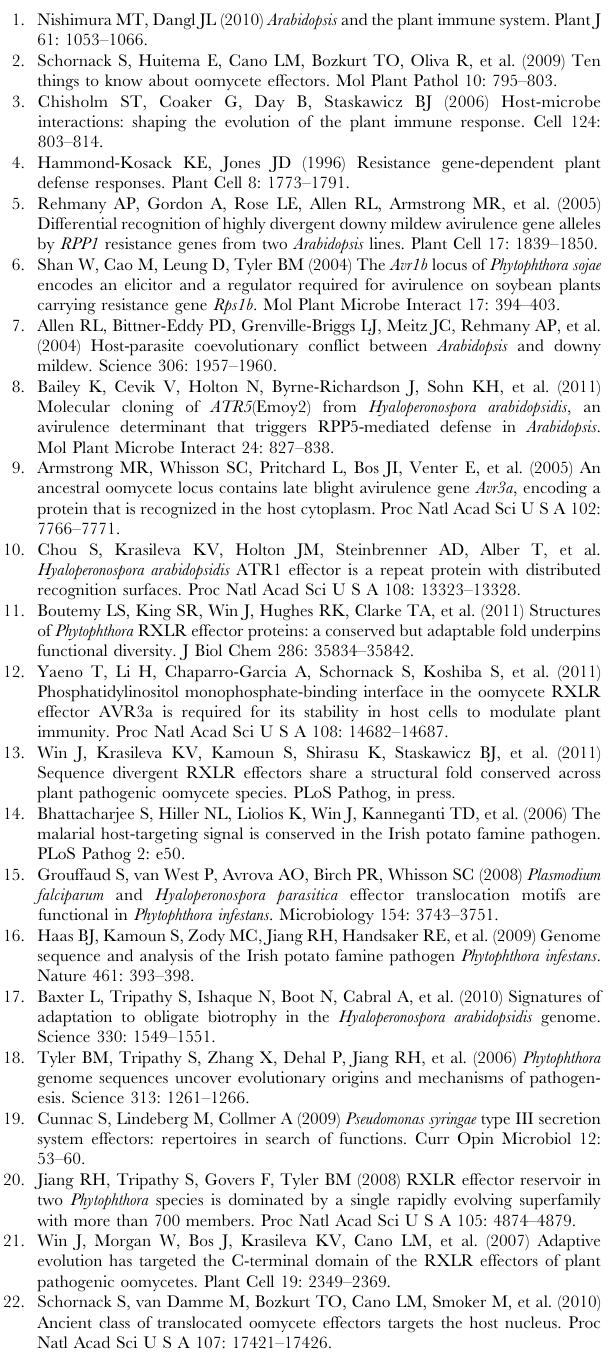
and red, respectively. Text S2 Fasta formatted nucleotide sequences of the top scoring effectors. Signal peptide sequences (not included in the cloned effectors) are highlighted in